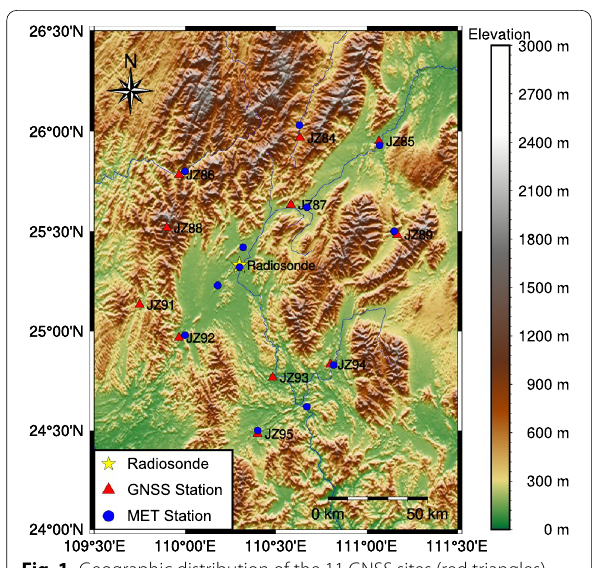
Fig. 1 Geographic distribution of the 11 GNSS sites (red triangles), 1 radiosonde station (yellow pentagram), and 12 ground meteorological (MET) stations (blue circles) in Guilin,